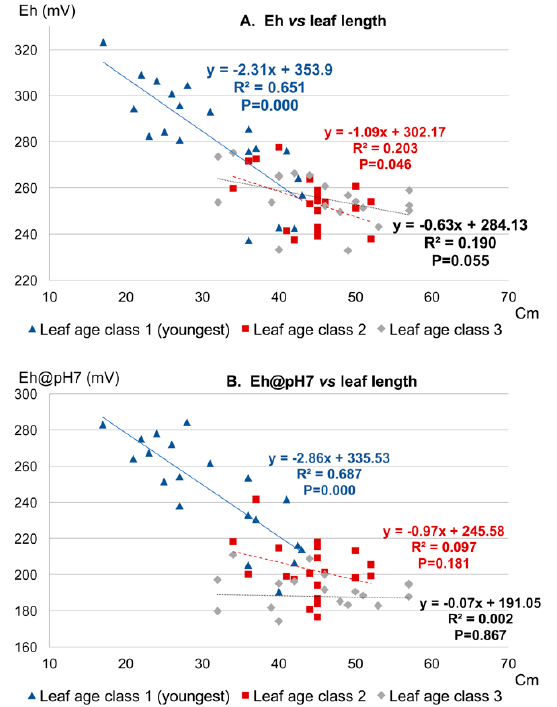
Figure 4. Correlation of leaf Eh ( A ) and Eh@pH7 ( B ) respectively with leaf length (cm) for 3 leaf age classes. Measurements made on the middle part of the leaf of four 61 to 64-day-old plants from season II, sown 17 August 2016 under upland management.